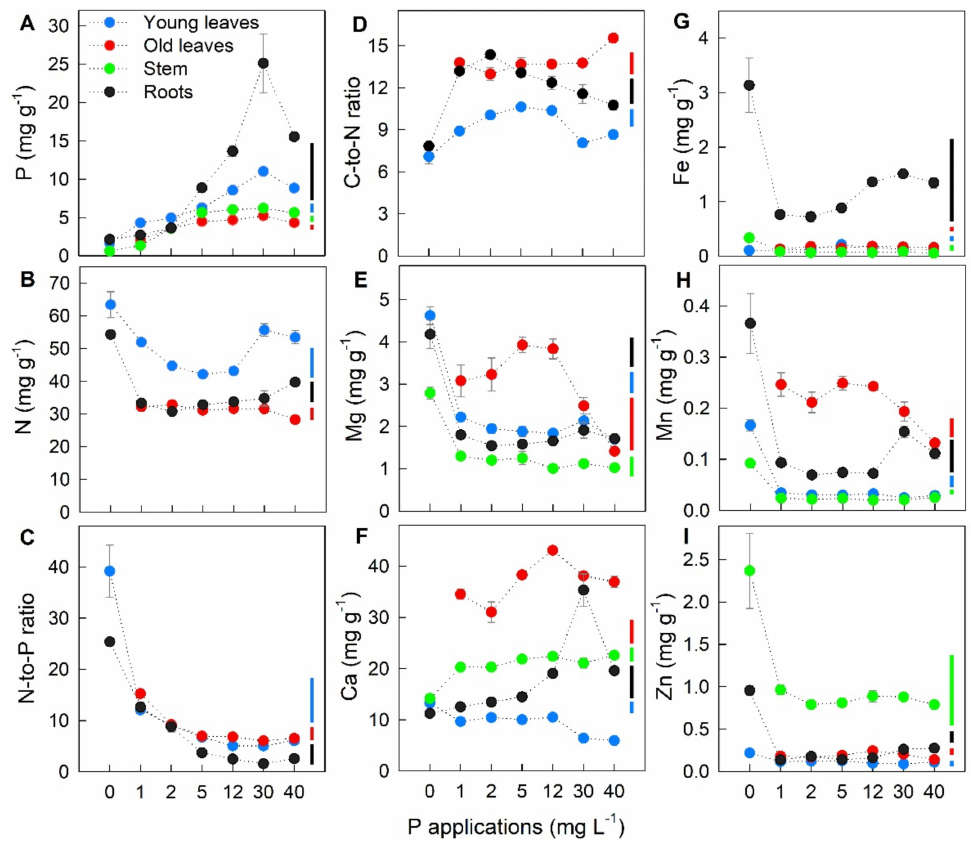
Figure 2. Effect of different P applications on ( A – B , E – I ) mineral concentration and ( C , D ) mineral ratios in young leaves, old leaves, stem, and roots. For all measured traits, P0 data for old leaves are missing due to insufficient sample material for analyses. Error bars indicate standard error of means ( n = 4). Vertical bars represent critical value for comparisons among P applications in each plant part by Tukey’s HSD test at p ≤